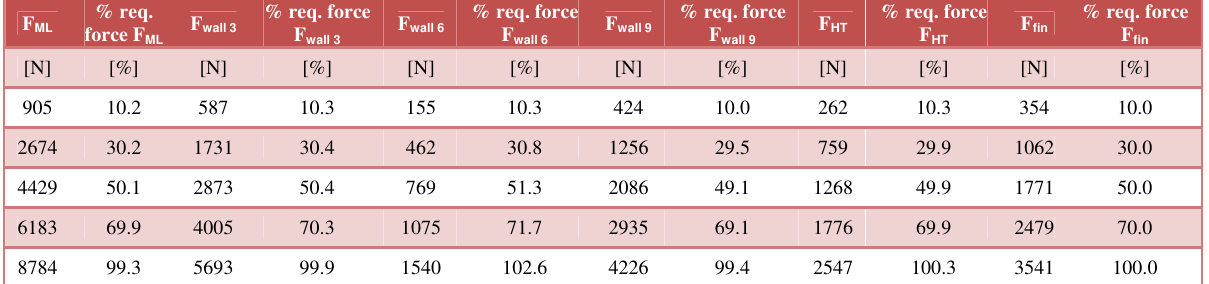
Table 6. Total forces during the test – case manoeuvre of vertical surfaces F summ. % req. force F tot.